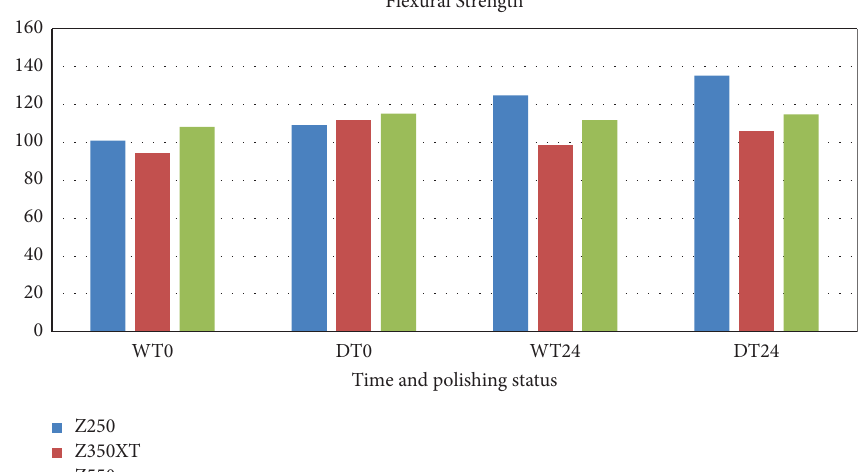
Figure 1: Te mean values of fexural strength for three diferent composites at immediately ( T polishing.